Question: Give a one-sentence summary of this figure.
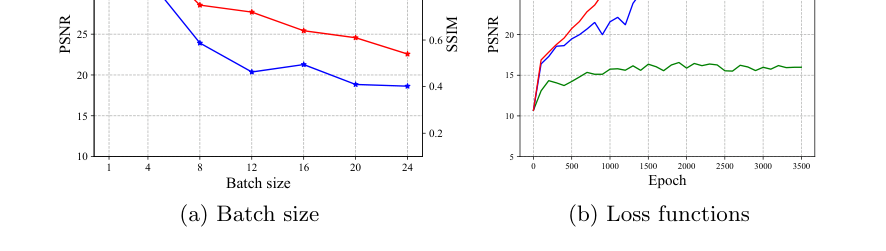
Answer: The effect of different batch sizes and loss functions on gradient inversion. GI-SMN utilizes an optimal loss function that enables efficient batch reconstruc- tion of images.